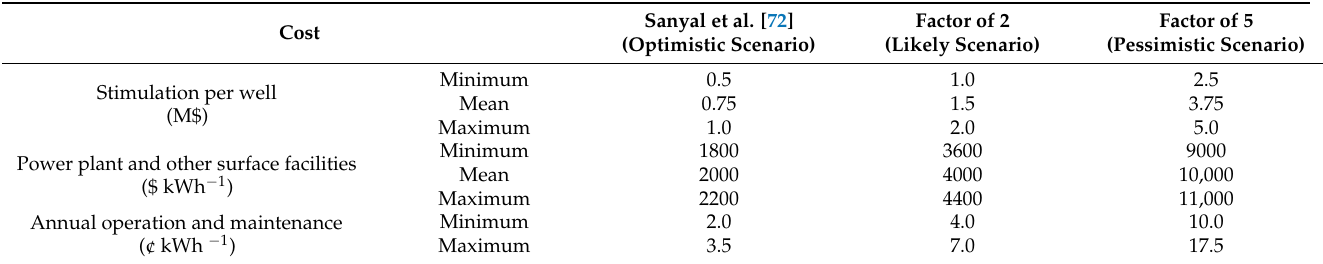
Table 2. Sensitivity analysis for the